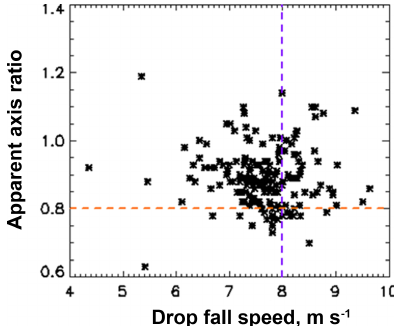
Figure 5. Rate of change of wind direction from the wind sensor for the 25 December 2009 event (Fig. 1) versus the 3.75–4.25mm drop fall speeds from the 2DVD. The purple dashed lines represent the expected fall speed range of drop fall